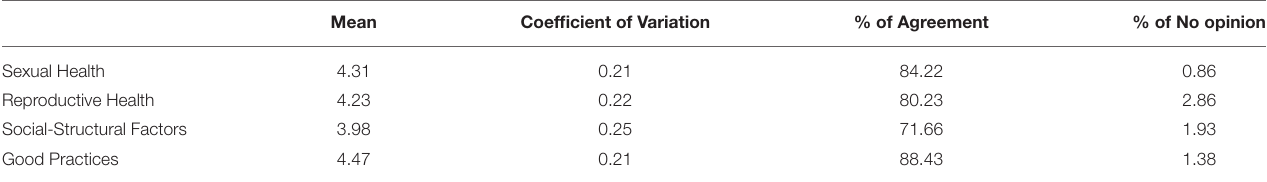
TABLE 4 | Mean values for response on Likert scale, Coefficient of variation, Percentage of “agreement” responses and Percentage of “no opinion” responses, by dimension.